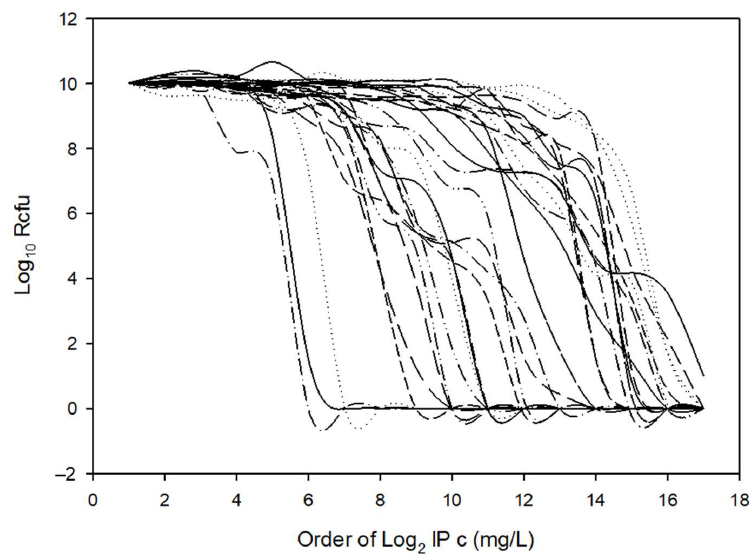
Figure 4. Cumulative PAP plots used in AUC calculations of our 15 B. fragilis test strains (Table 1) cultured on solid (supplemented Columbia blood agar) or in liquid (BHIS) media.